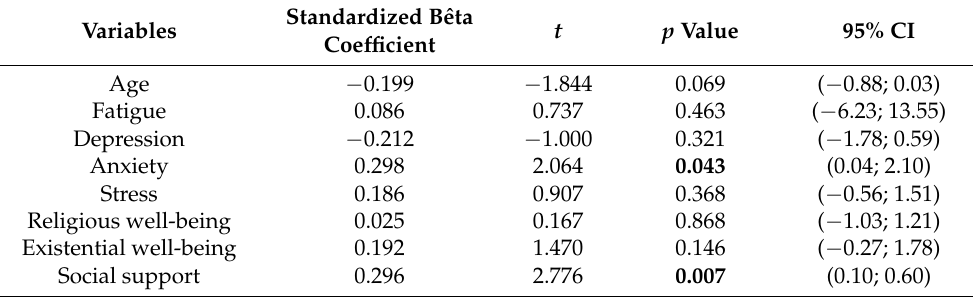
Table 5. Multiple linear regression analyses correlating PTG to study variables in our sample ( n =